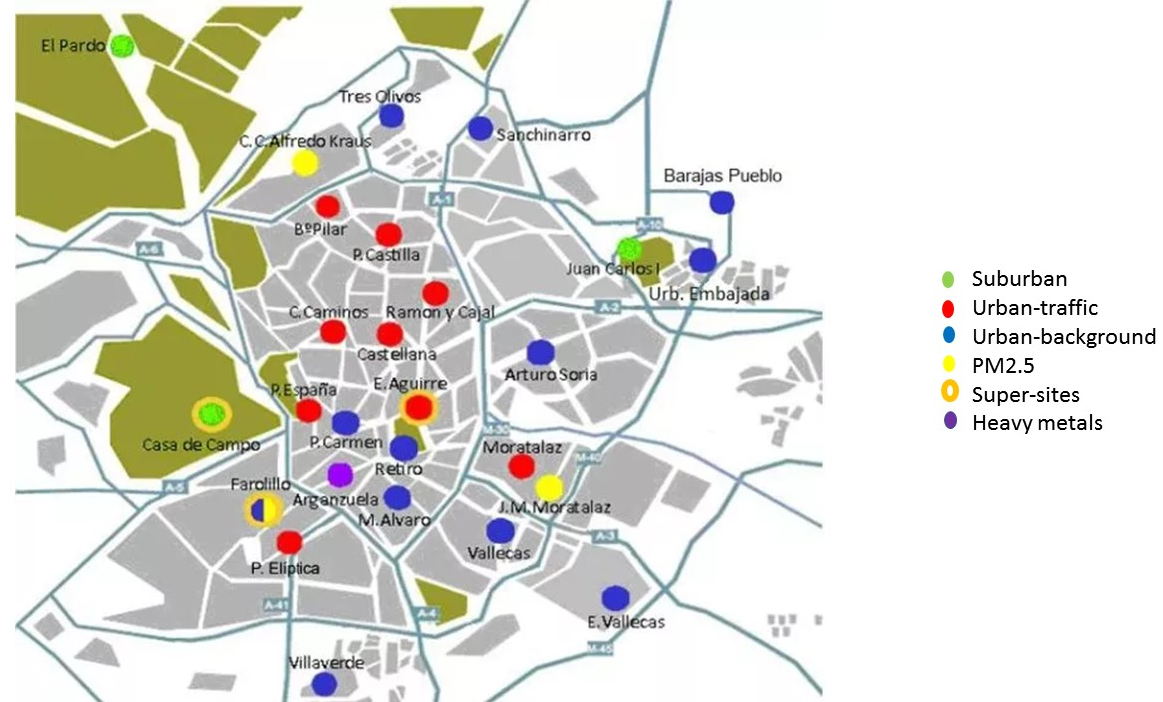
Figure 2. Location of the NO x MS operating in the city of Madrid in the period 2000–2009. Source: Own elaboration from www.madrid.com accessed on 15 March 2021.